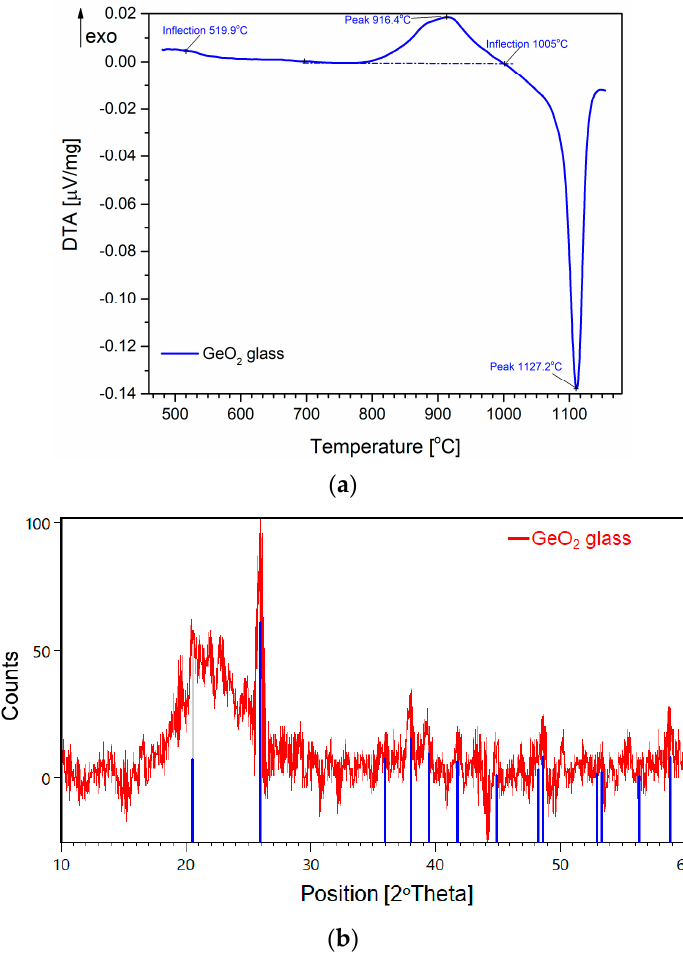
Figure 1. Results of the investigations: ( a ) crystallization and melting on the DTA curve (at step 10 °C/min); and ( b ) X-ray diffraction pattern of pure GeO 2 glass.